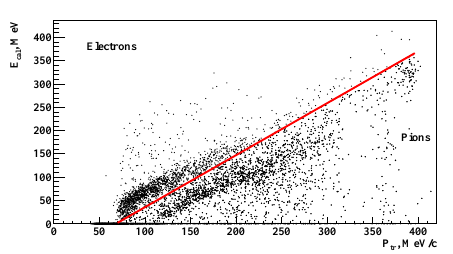
Figure 2. 2D-distribution on total momentum and 2 E beam − E tot in data (black plus) and MC (red dots). The thick line shows boundaries of these parameters.